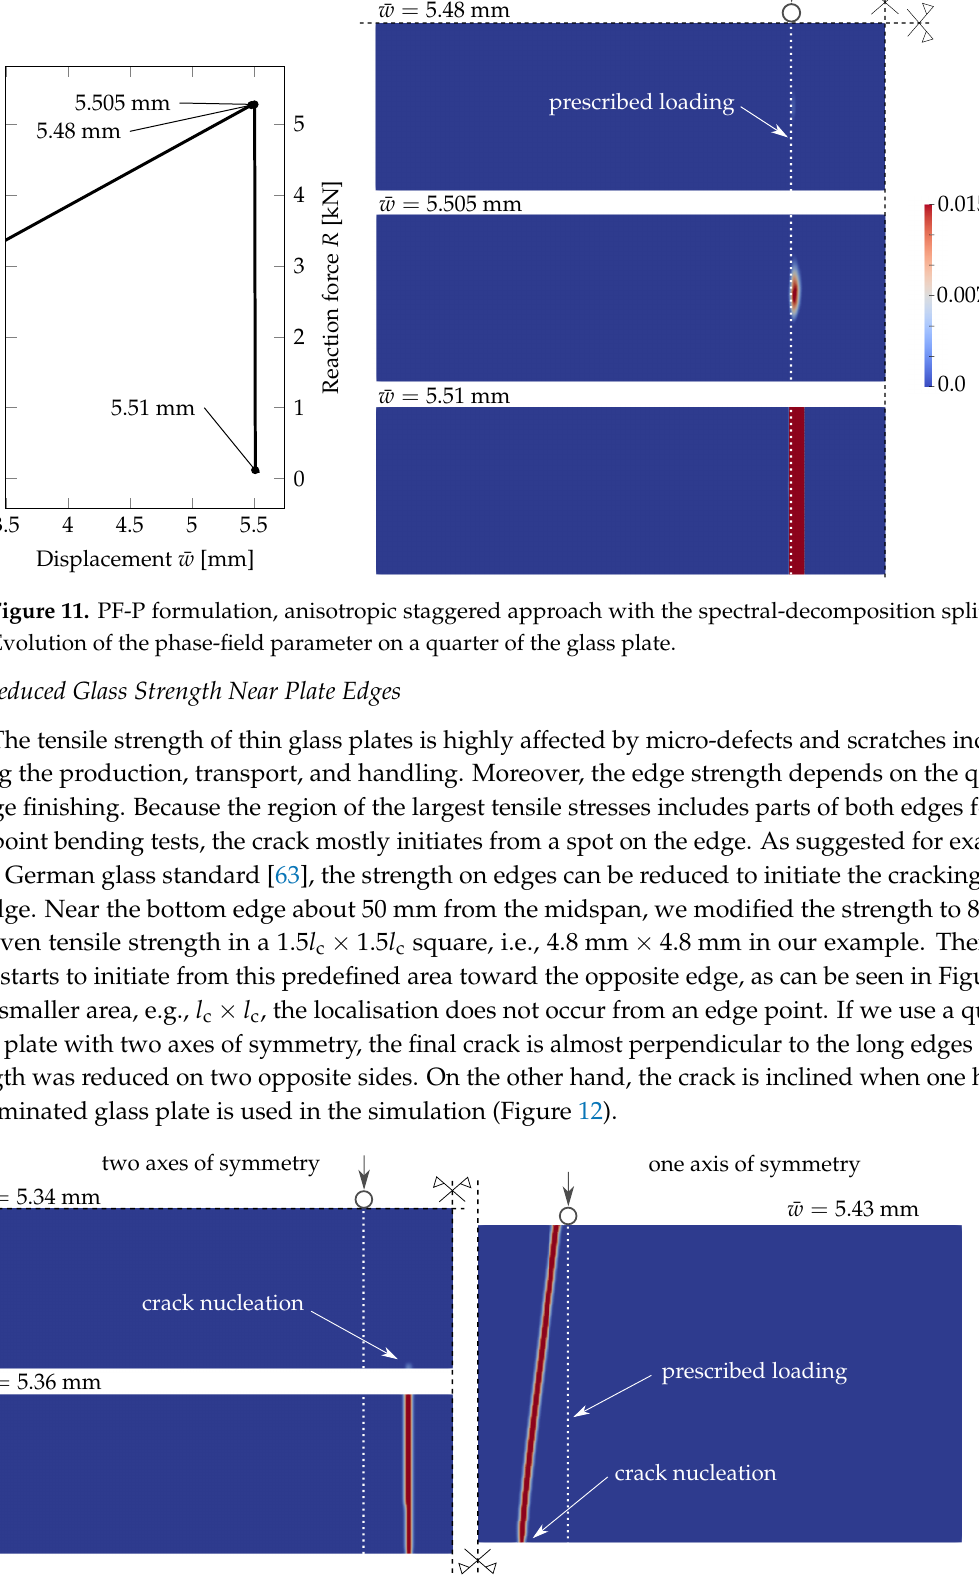
Figure 12. PF-P formulation, P mesh, anisotropic staggered approach with the spectral-decomposition split: Evolution of the phase-field parameter on a quarter of the glass plate and the final crack pattern on a half of the